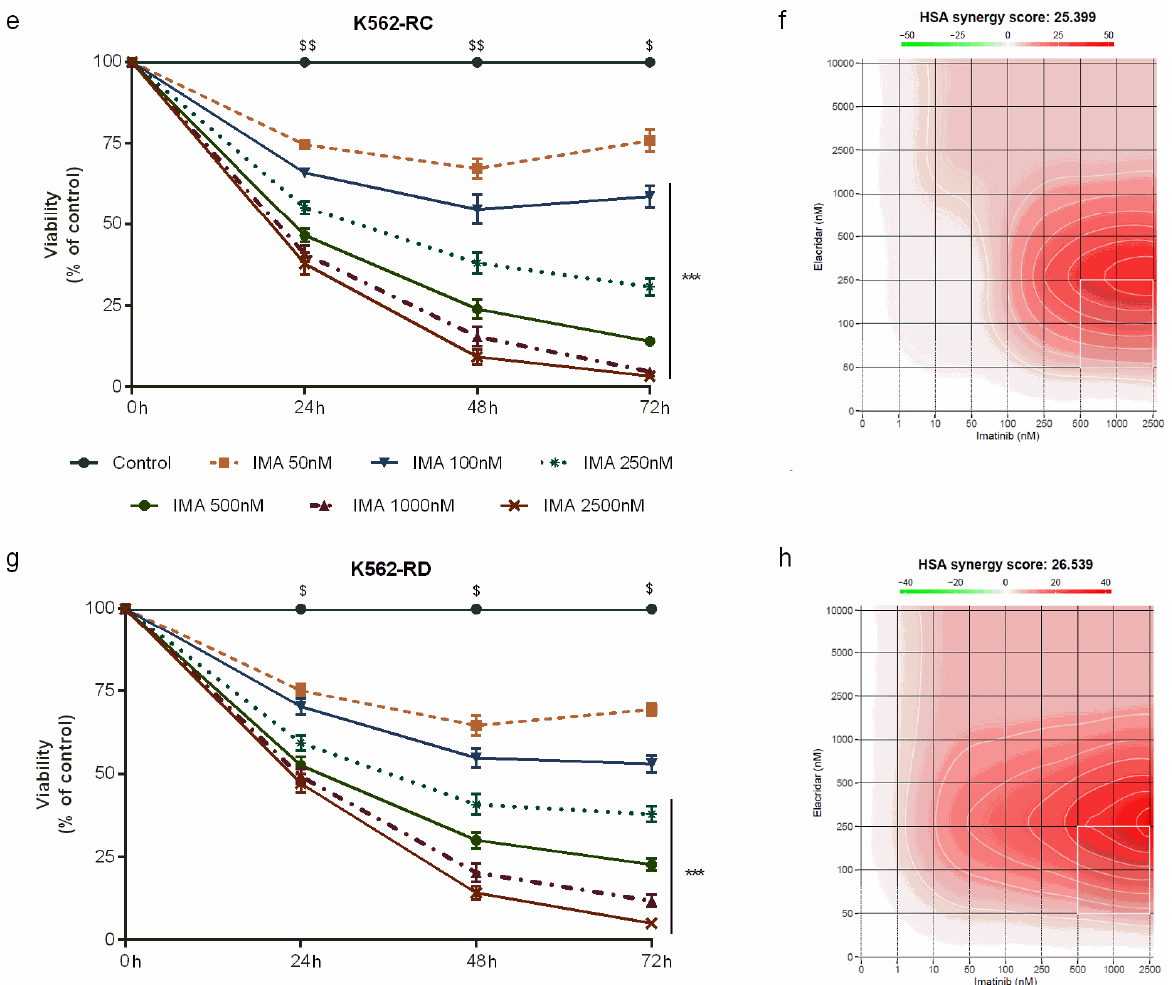
Figure 3. Dose–response curves of imatinib plus elacridar on sensitive and imatinib-resistant Figure 3. Dose – response curves of imatinib plus elacridar on sensitive and imatinib ‐ resistant CML cell lines. K562 ( a ), LAMA ‐ 84 ( c ), K562 ‐ RC ( e ), and K562 ‐ RD ( g ) cells were incubated in the absence and presence of different concentrations of imatinib in combination with elacridar 0.25 μ M during 72h. The control cells correspond to cells treated with 0.25 μ M of elacridar. Results were expressed